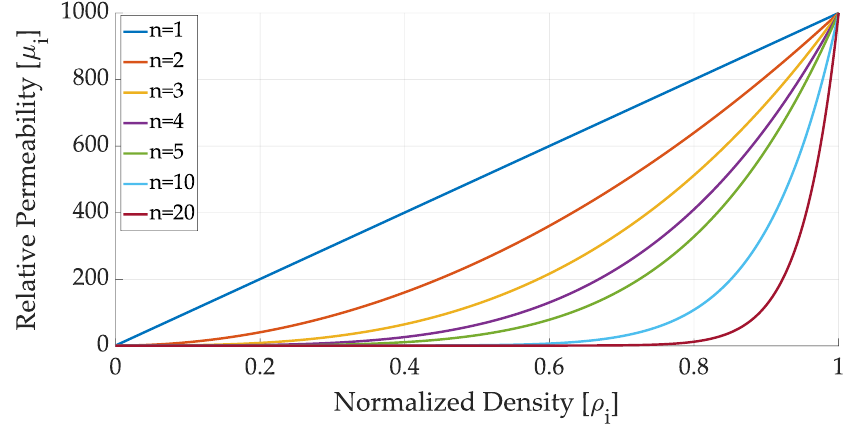
Figure 1. Various interpolation schemes characterized by a penalization